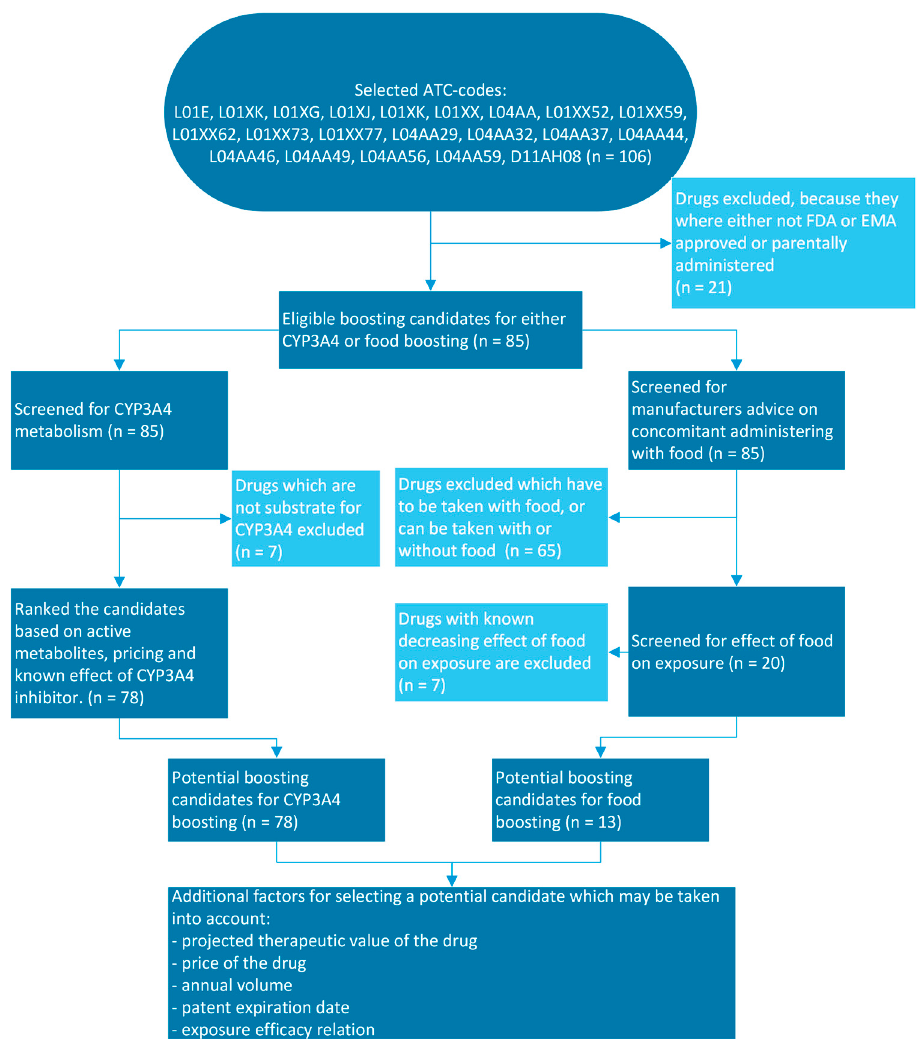
Figure 1. QuickScan algorithm for selecting either CYP3A4 or food boosting